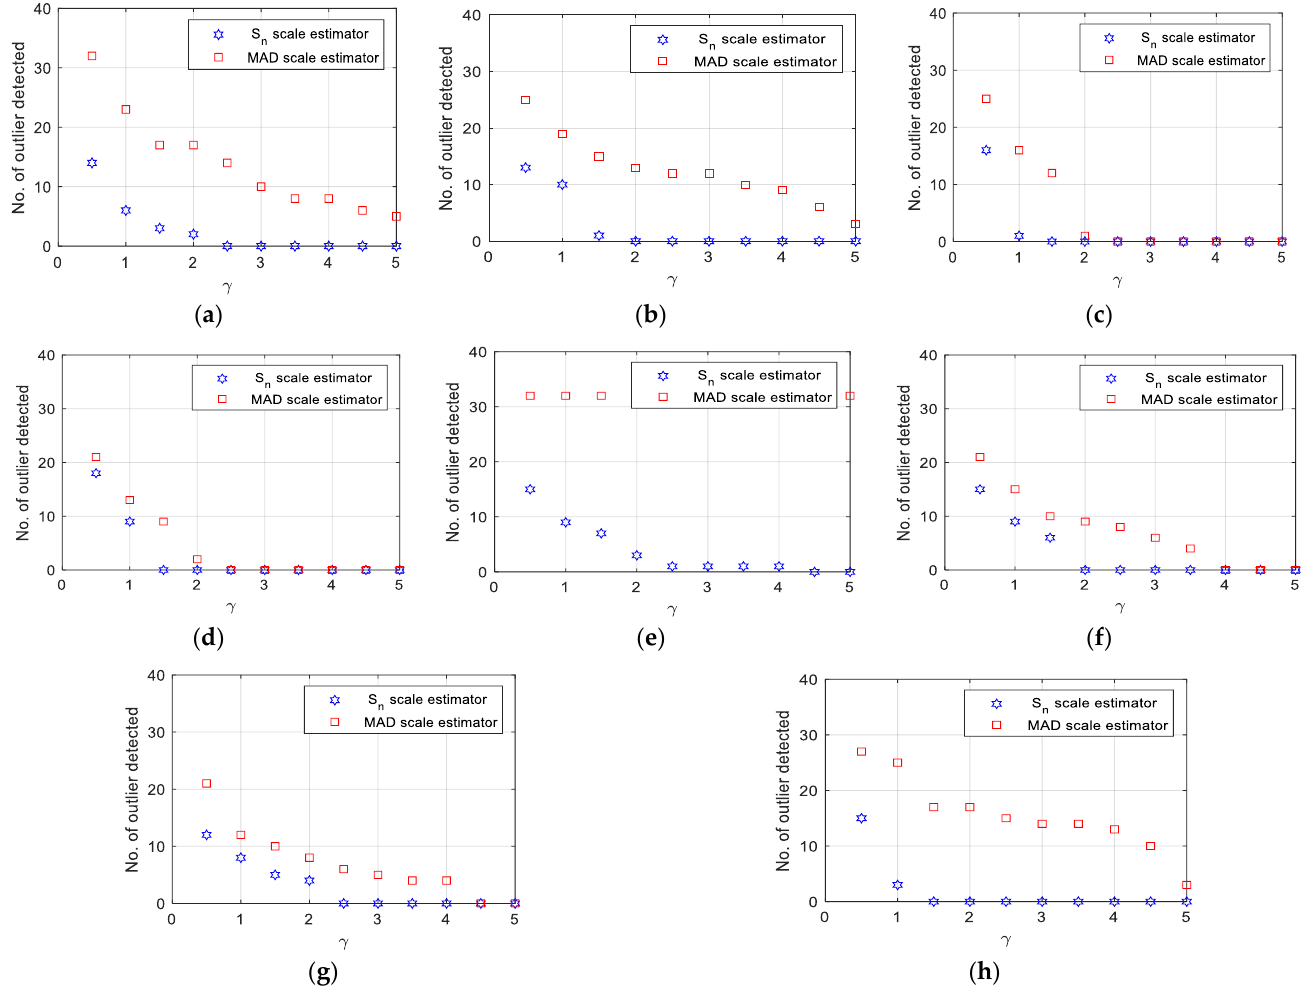
Figure 2. Number of detected RSS outliers for different γ values: ( a ) RSS observation 1, ( b ) RSS observation 2, ( c ) RSS observation 3, ( d ) RSS observation 4, ( e ) RSS observation 5, ( f ) RSS observation 6, ( g ) RSS observation 7, and ( h ) RSS observation 8.